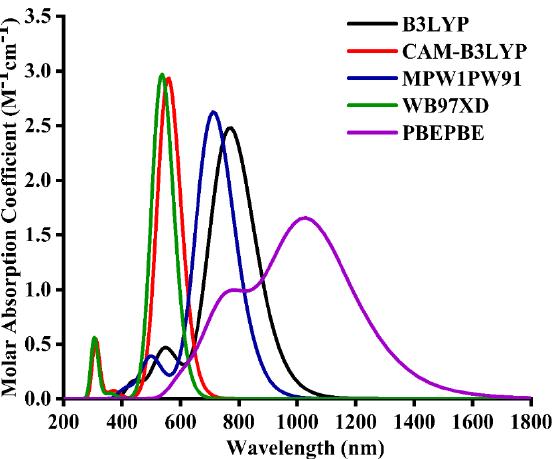
Figure 2. Comparison of BTIC − R solvent phase absorption values at diverse functionals.